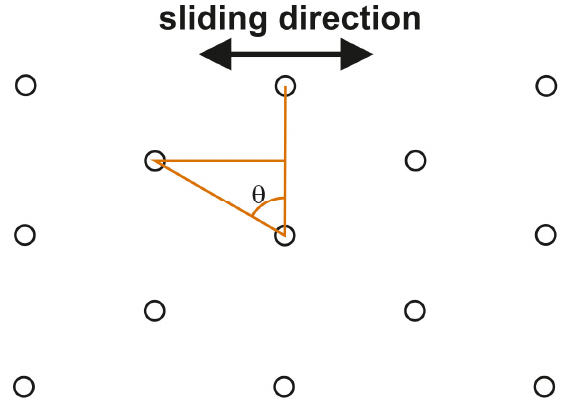
Figure 2. The scheme of laser-textured cylinder liner, after [63].